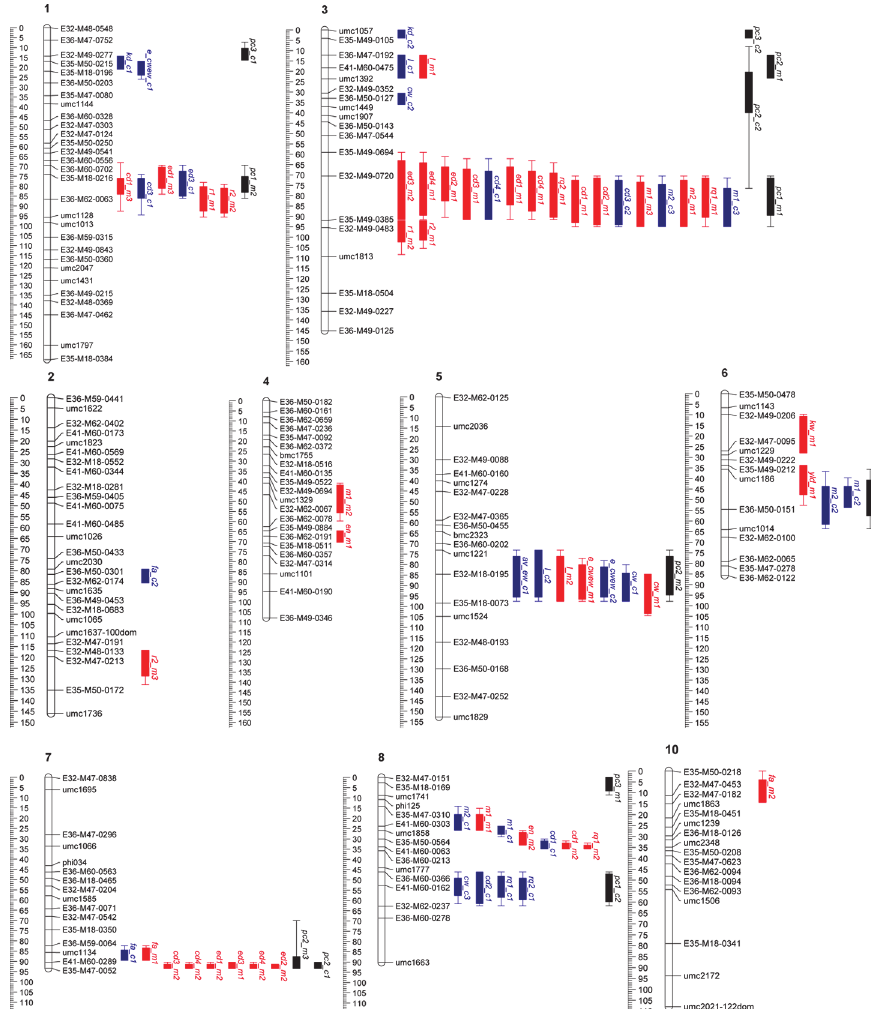
Fig 1. QTL detected for ear fasciation and related traits using 149 F 2:3 families (PB260 (non-fasciated) x PB266 (fasciated)) at two environments in Portugal (Coimbra and Montemor). Bar positions indicate the locations of quantitative trait loci (QTL): outer and inner interval correspond to 1-LOD and 2-LOD support interval, and are indicated as full box and a single line respectively. QTL nomenclature was arranged by the trait name plus environment abbreviation (c = Coimbra and m = Montemor) and the order number of detected QTL for the same trait in the genome (the higher the n°, the lower the contribution of the detected QTL for the explained phenotypic